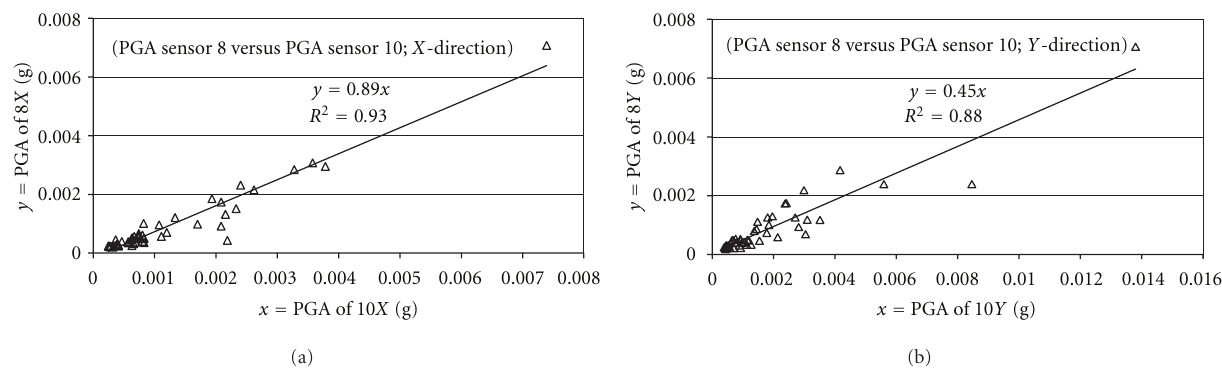
Figure 6: PGA at base of building B recorded by sensor 8 versus PGA at free field recorded by sensor 10: (a) X -direction and (b) Y -direction.